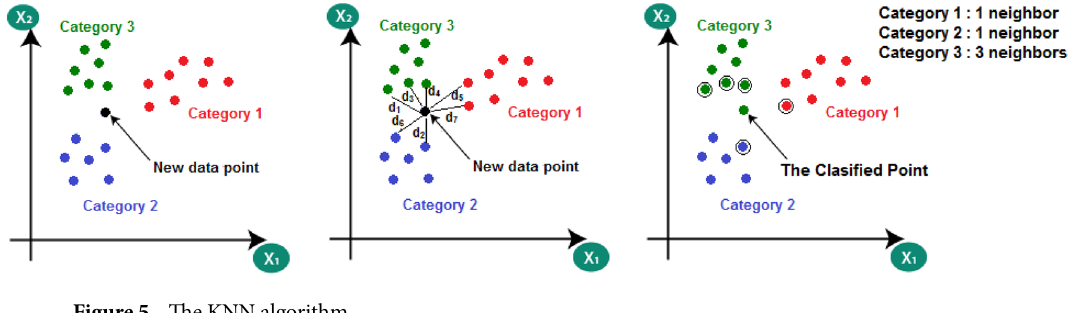
Figure 5. The KNN